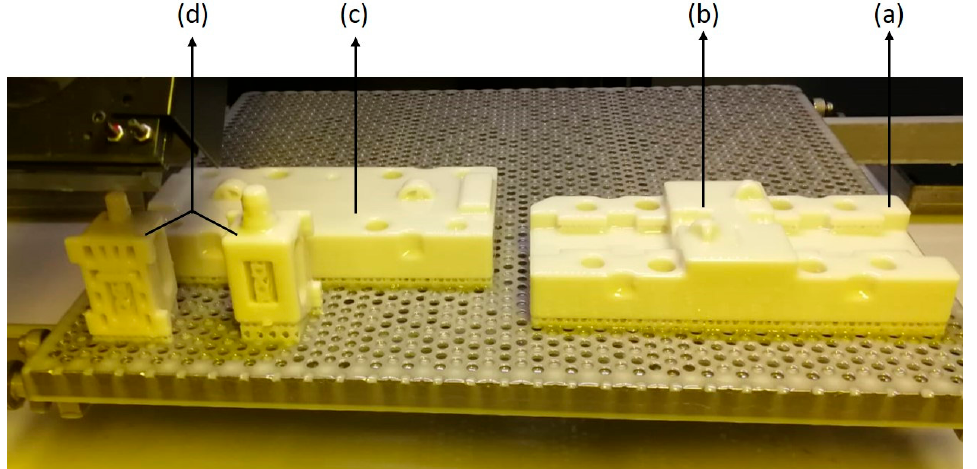
Figure 5. Overview of the soft tooling components that are printed with digital light processing (DLP): ( a ) ejector mold; ( b ) cavity; ( c ) injection mold; ( d ) slides M18 and M14.